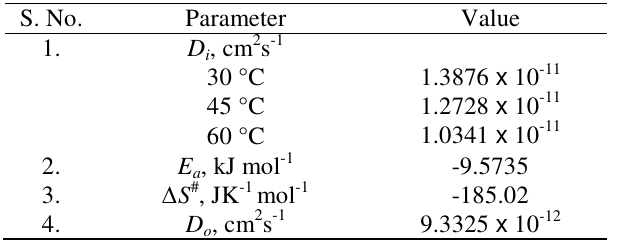
entropy of activation ∆ S # and pre-exponential a,